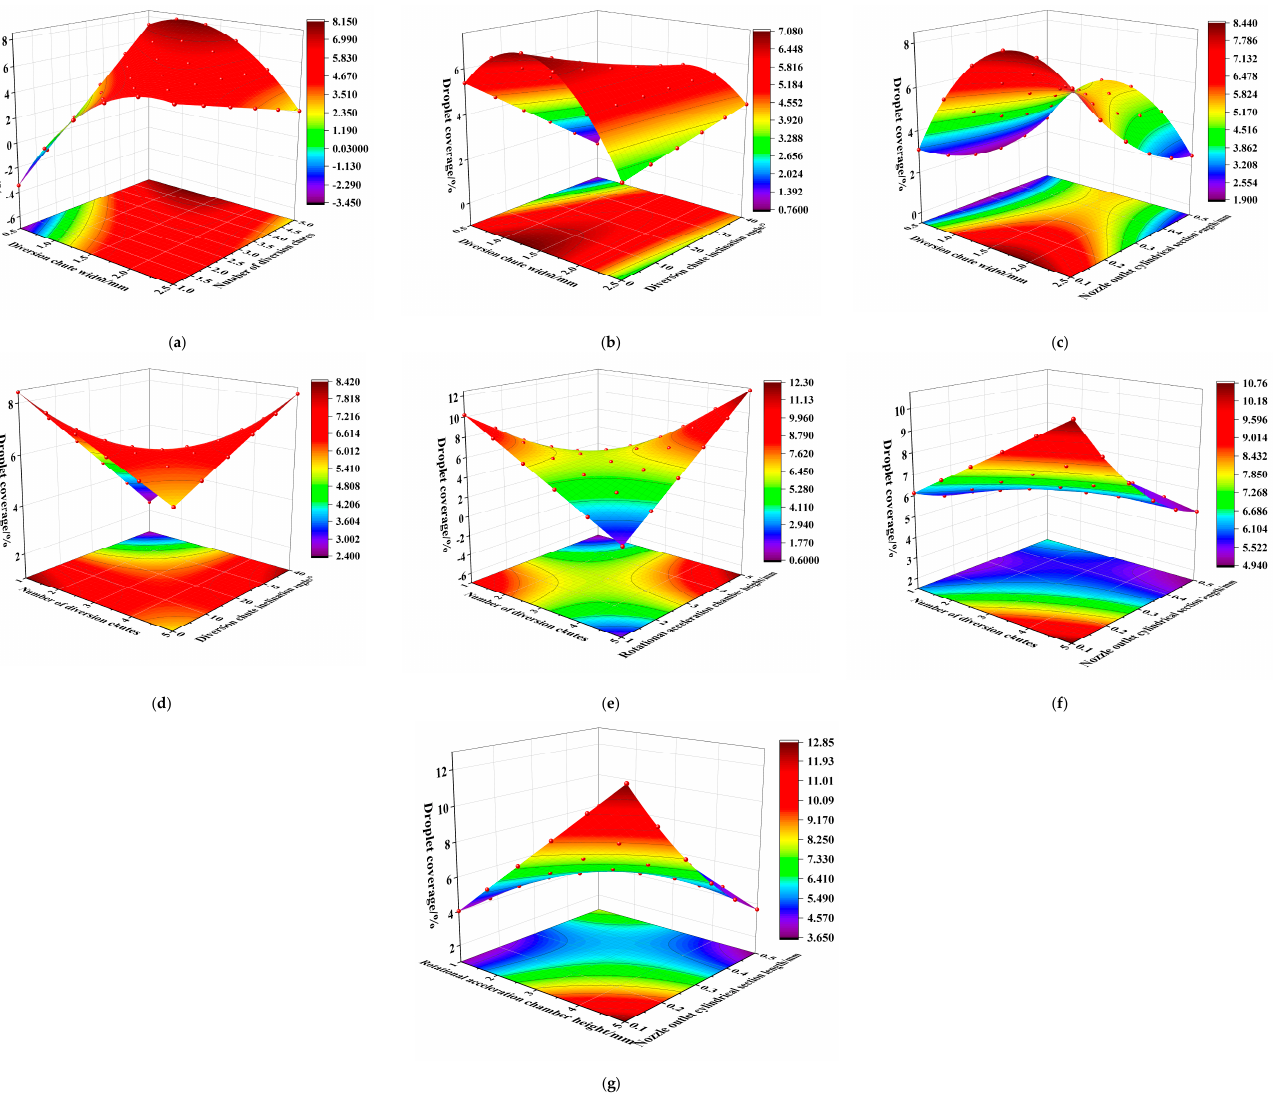
Figure 13. Two-factor interaction effect diagram of the droplet coverage. ( a ) Interaction effect between b and n , ( b ) interaction effect between b and β , ( c ) interaction effect between b and h 2 , ( d ) interaction effect between n and β , ( e ) interaction effect between n and h 1 , ( f ) interaction effect between n and h 2 , ( g ) interaction effect between h 1 and h 2.